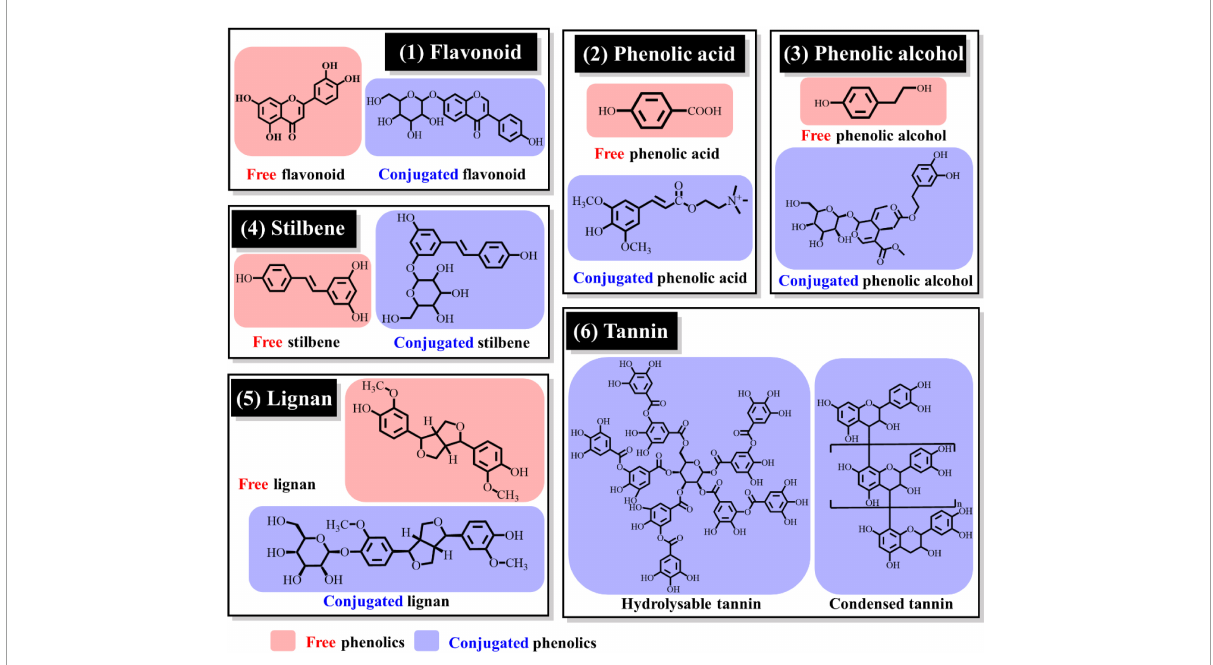
FIGURE1 Classification and structures of representative phenolic